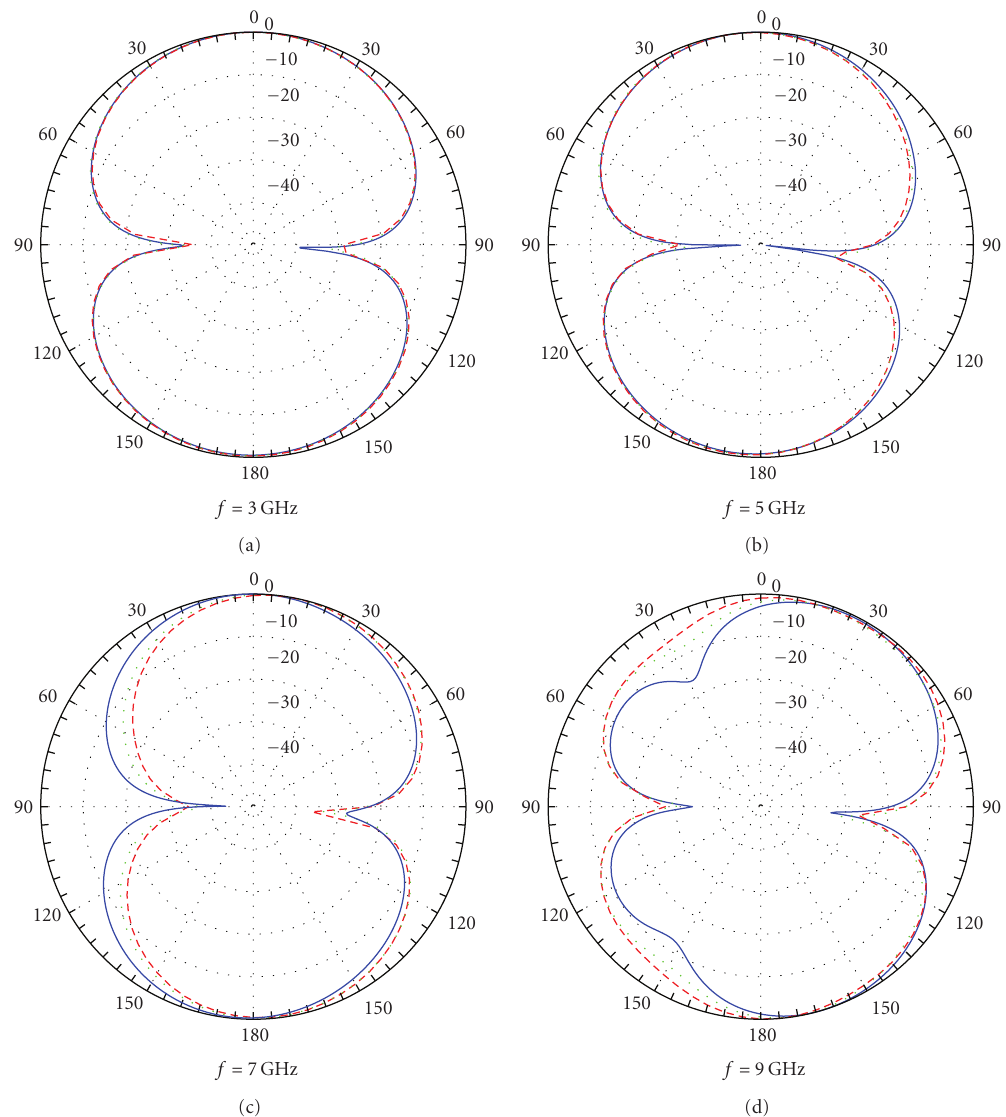
Figure 9: Simulated E -plane ( XZ -plane) radiation patterns for the two-element UWB array at di ff erent element spacing values d = 28 mm (solid line) and d = 54 mm (dashed line) compared to a single antenna element (dotted